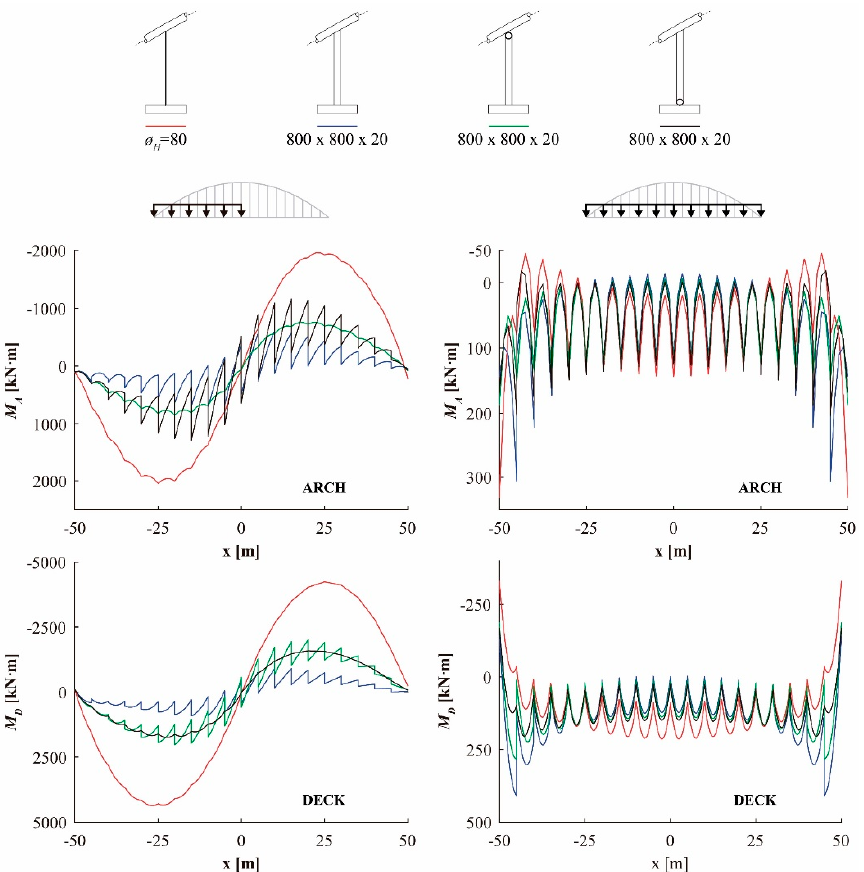
Figure 9. Pinned and stiff hangers comparison: Bending moments at the arch and the deck.